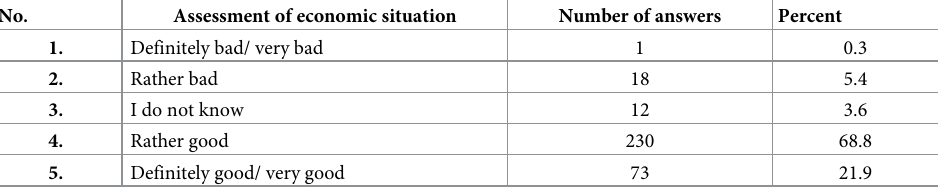
Table 6. Characteristics of the surveyed women with regard to the assessment of their economic situation. N = 334. Source: Study by Ewa Krause.